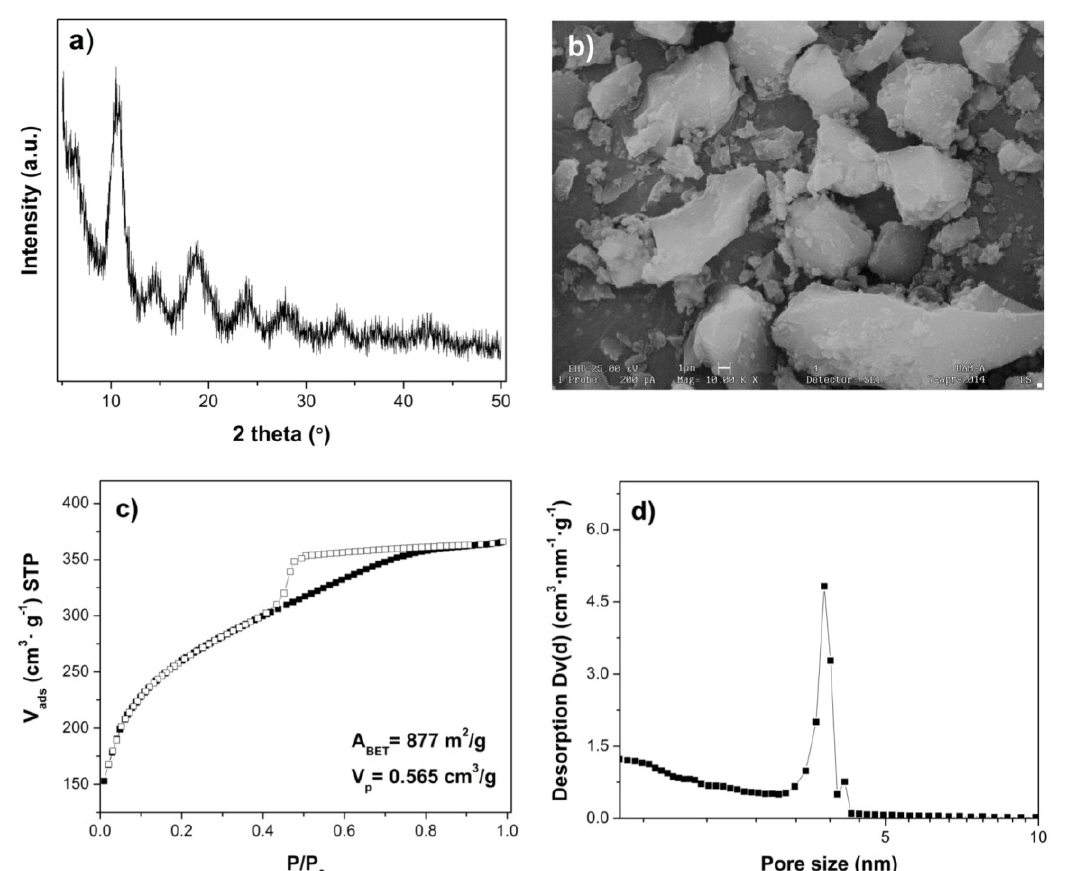
Figure 1. ( a ) Powder XRD pattern; ( b ) SEM image; ( c ) N 2 adsorption isotherm